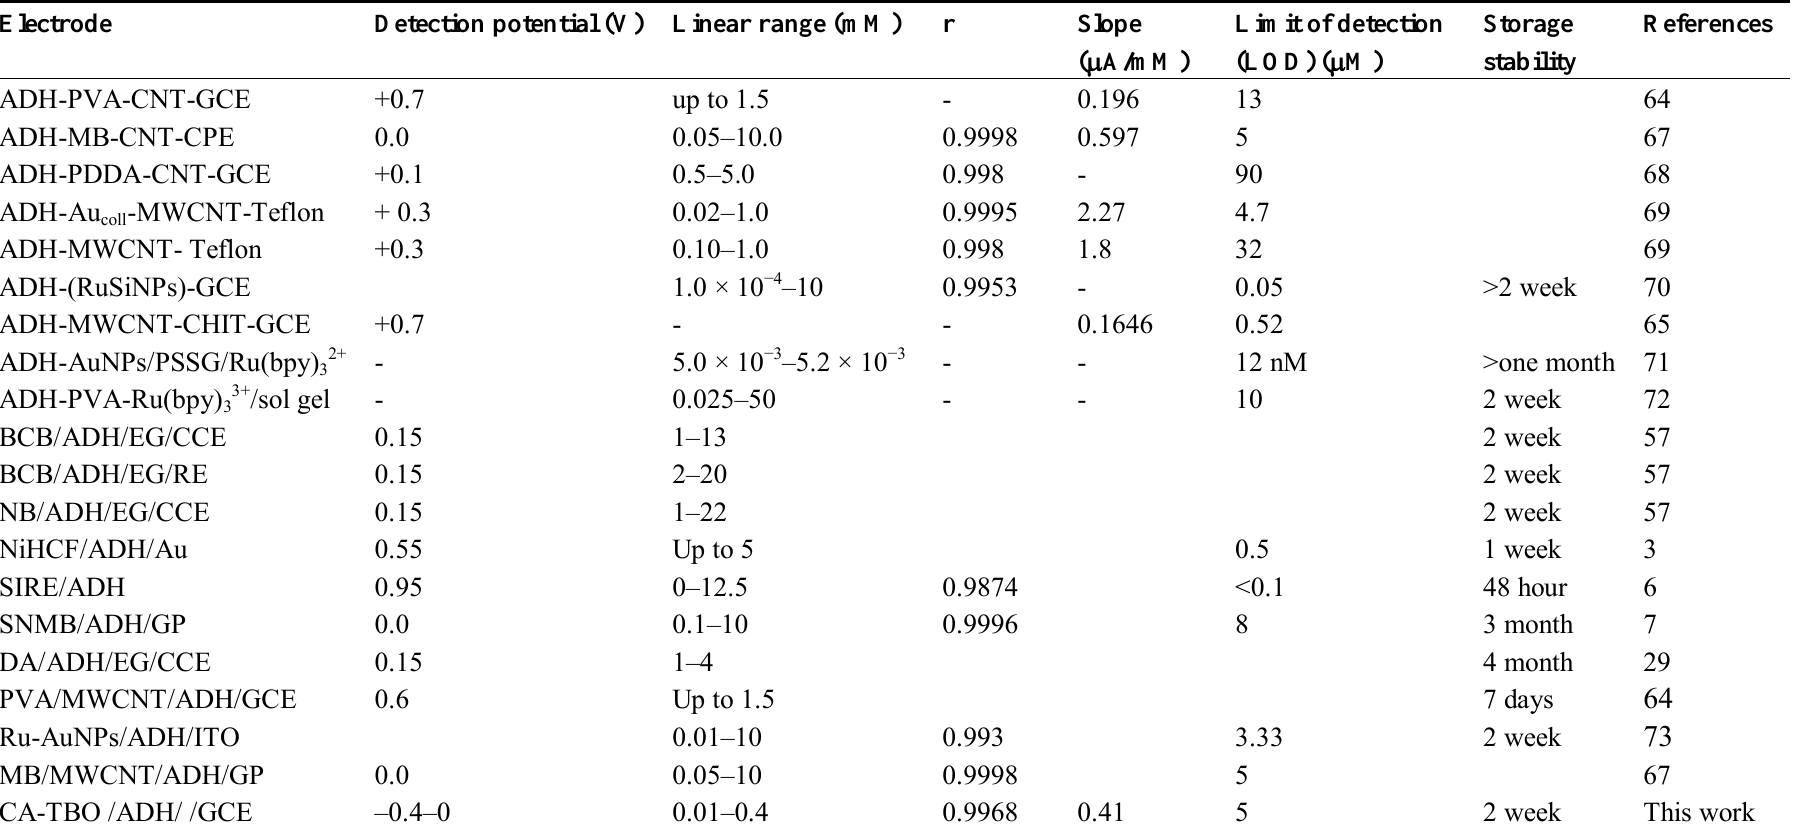
Table 3. Analytical characteristics of ADH based biosensors for ethanol